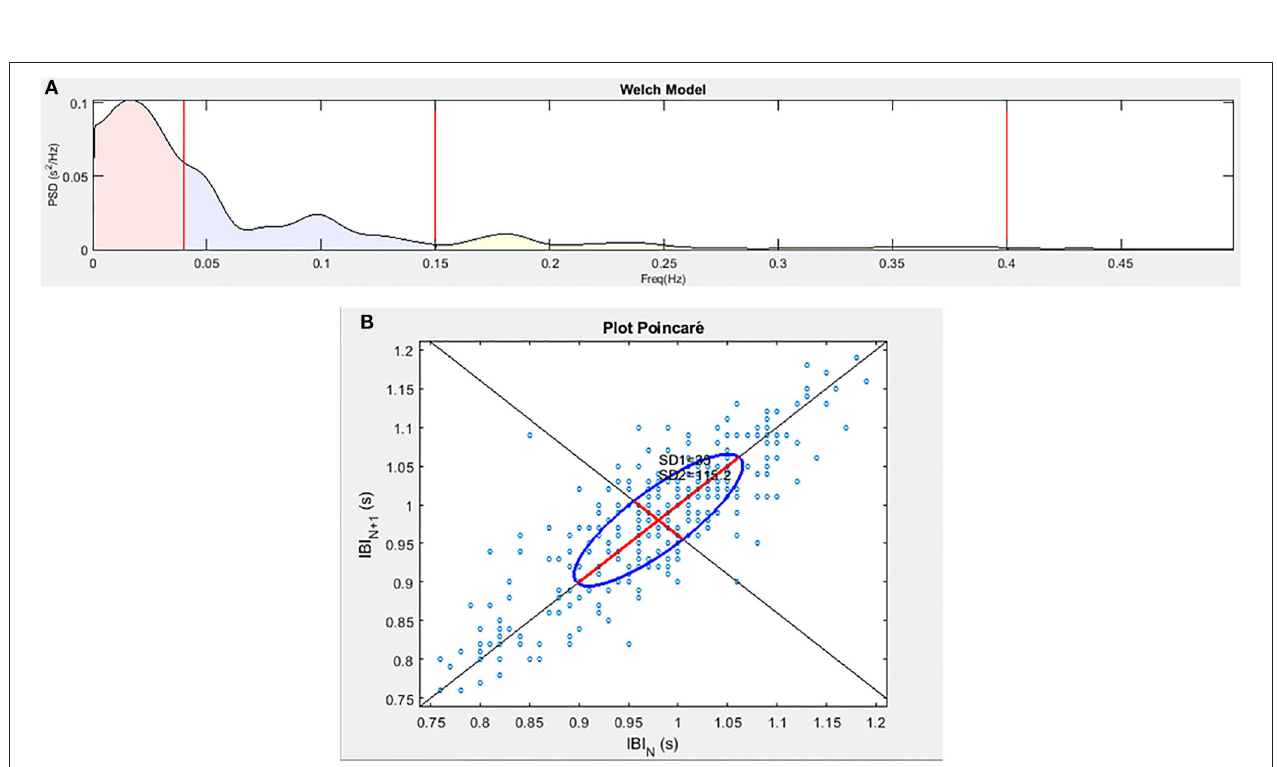
FIGURE 2 | An example of the frequency spectra (A) and of the Poincaré plot (B) for a sample individual enrolled in the study.